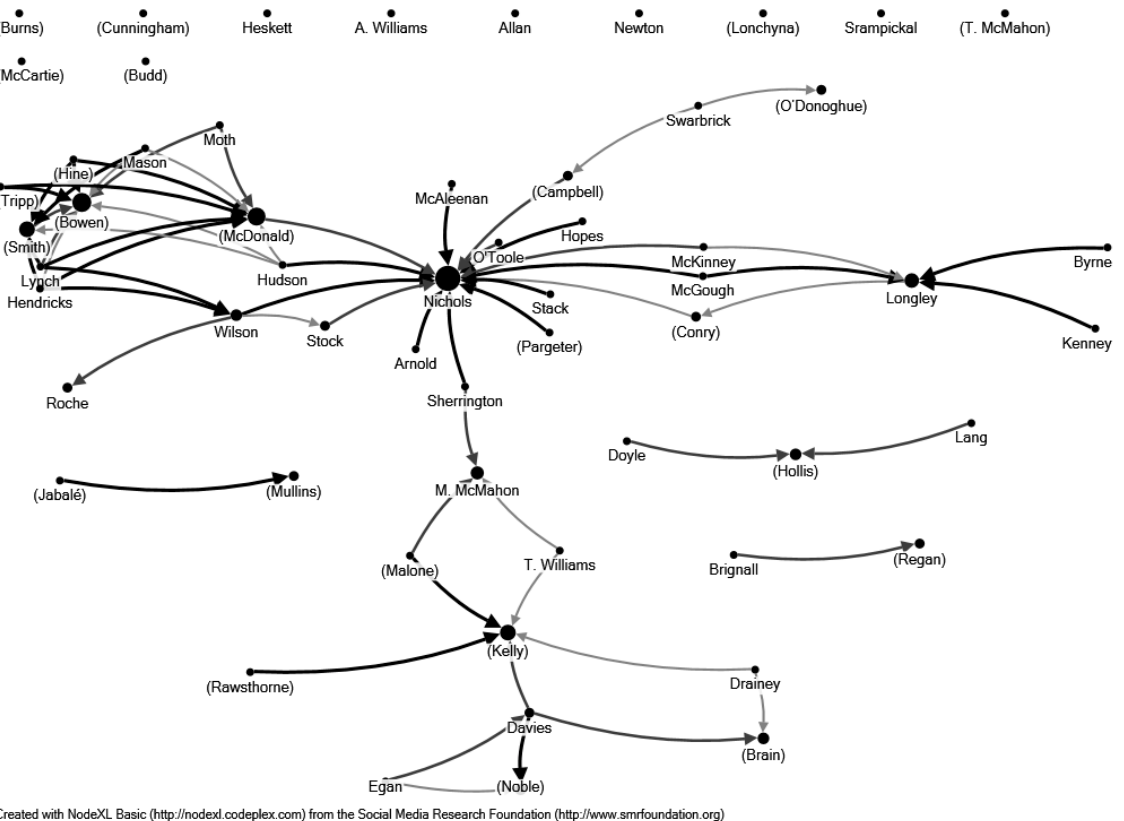
Figure 1. Network map of living members of the Catholic Bishops’ Conference of England and Wales, both active and retired (October 2019).